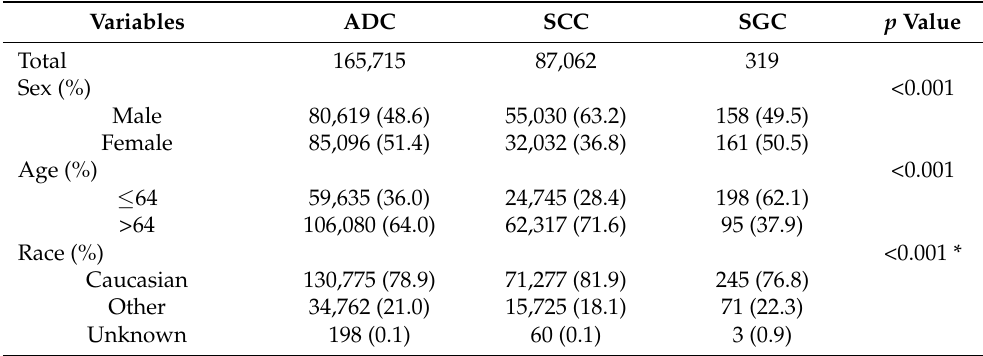
Table 1. Clinical and pathological characteristics of lung cancer patients from the Surveillance Epidemiology and End Results database between 2004 and